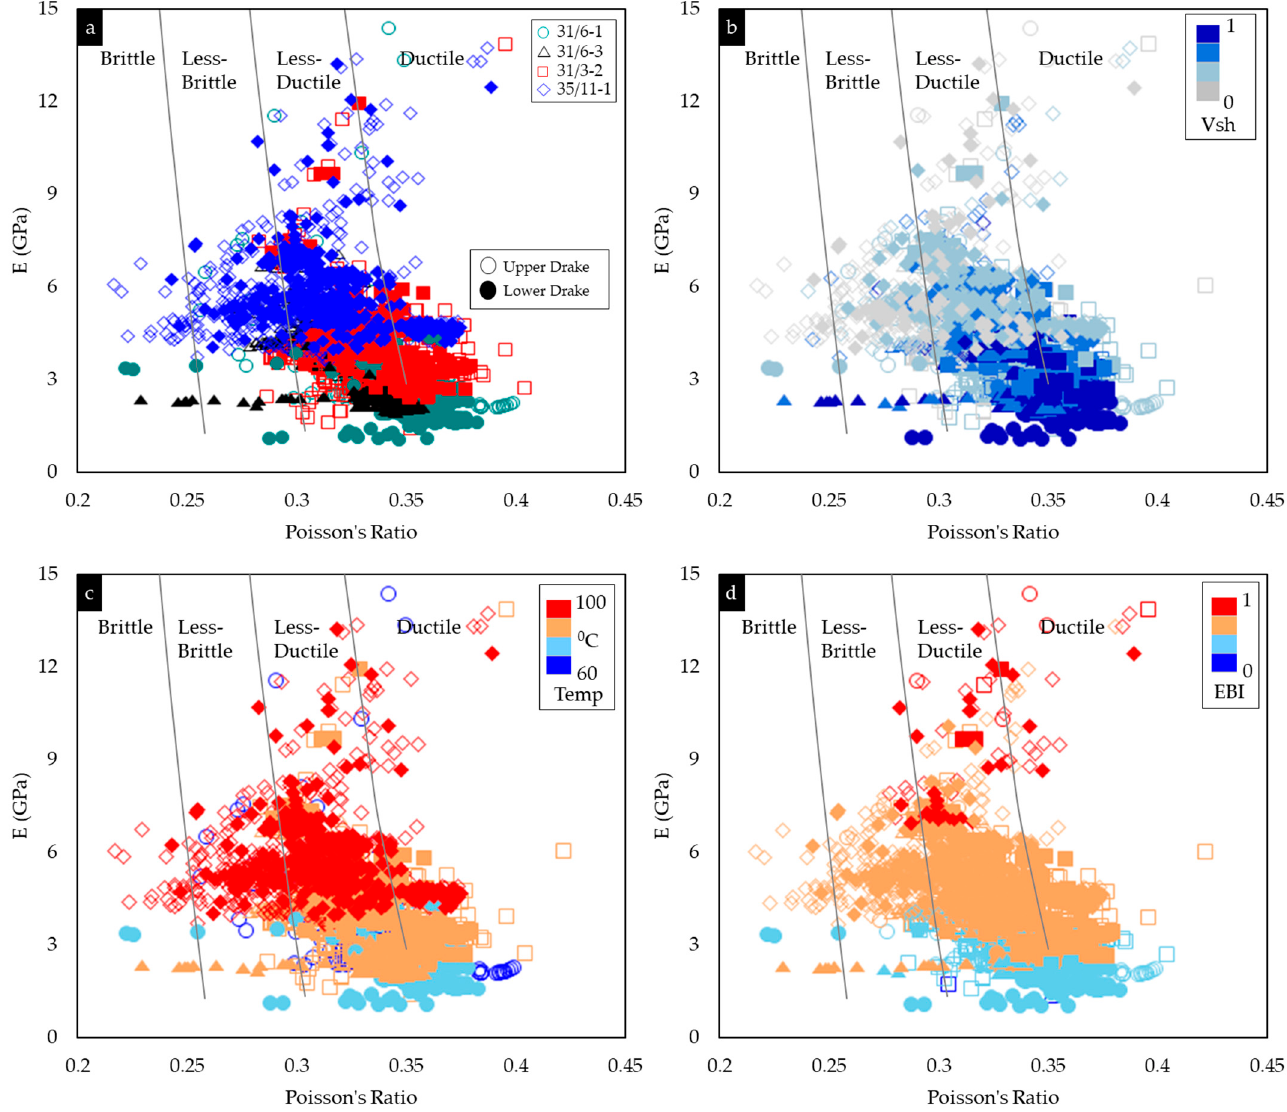
Figure 12. Young’s modulus versus Poisson’s ratio cross-plots of Drake Formation show the variations between upper (non-filled) and lower (filled) Drake units color-coded with well names ( a ), the volume of shale ( b ), temperature corrected for exhumation ( c ), and EBI ( d ). The reference background curves are adapted from Perez and Marfurt [50].